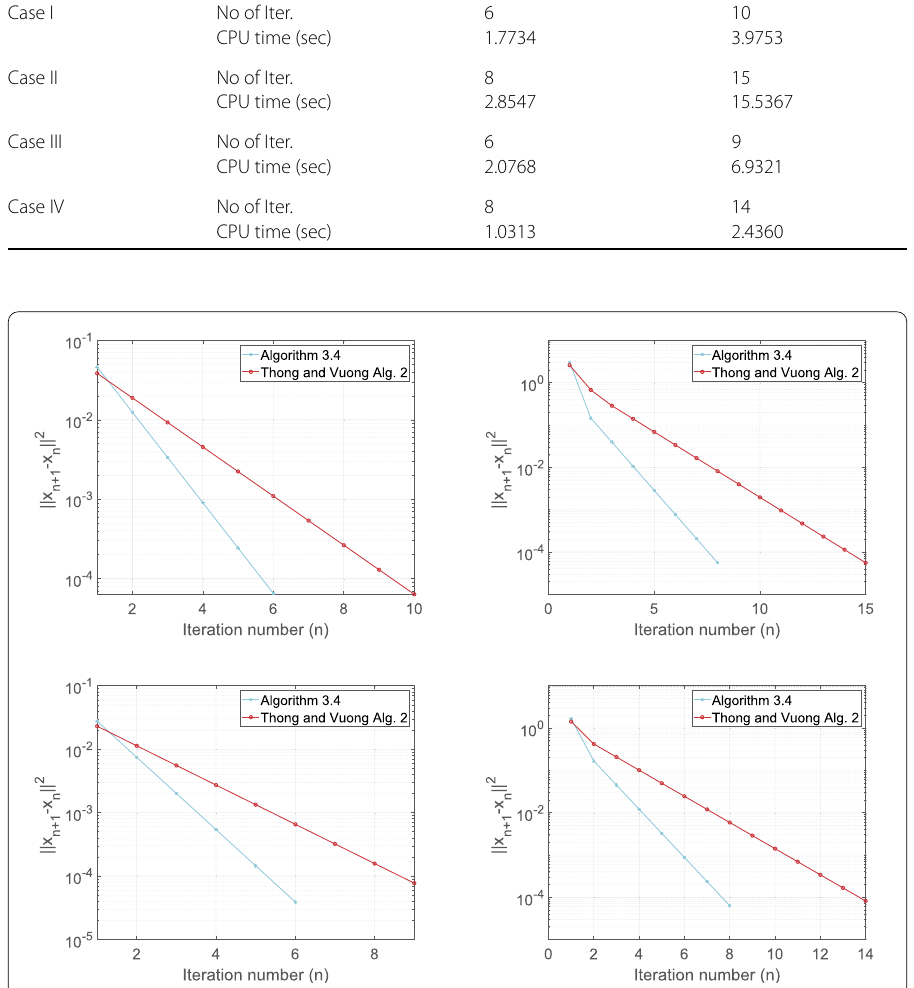
Figure 2 Experiment 2, top left: Case I; top right: Case II; bottom left: Case III; bottom right: Case